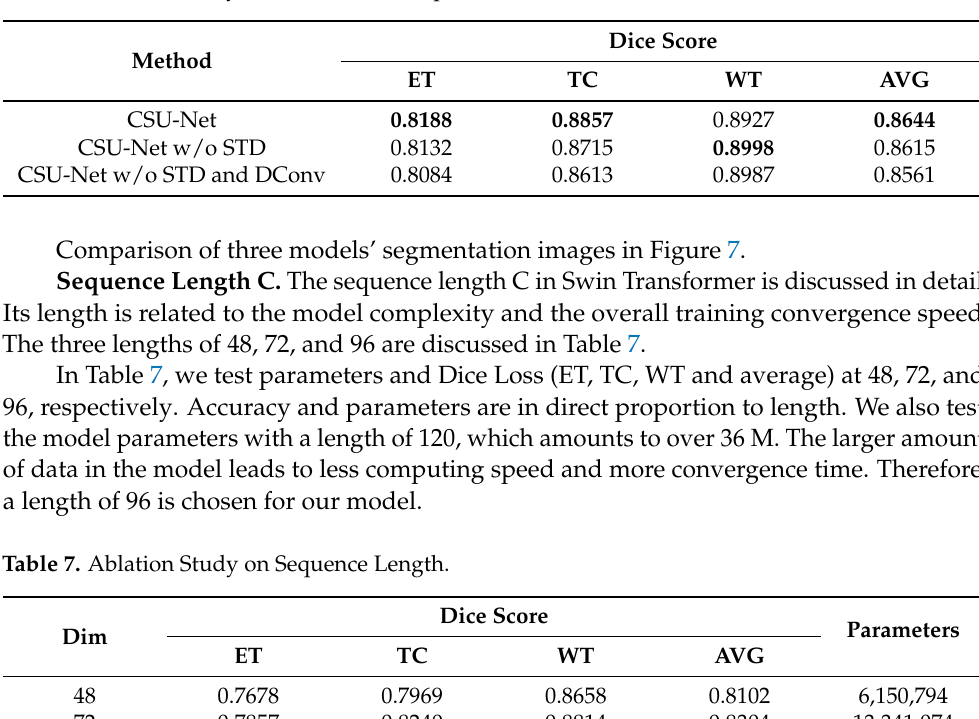
Table 6. Ablation Study on Individual Components.